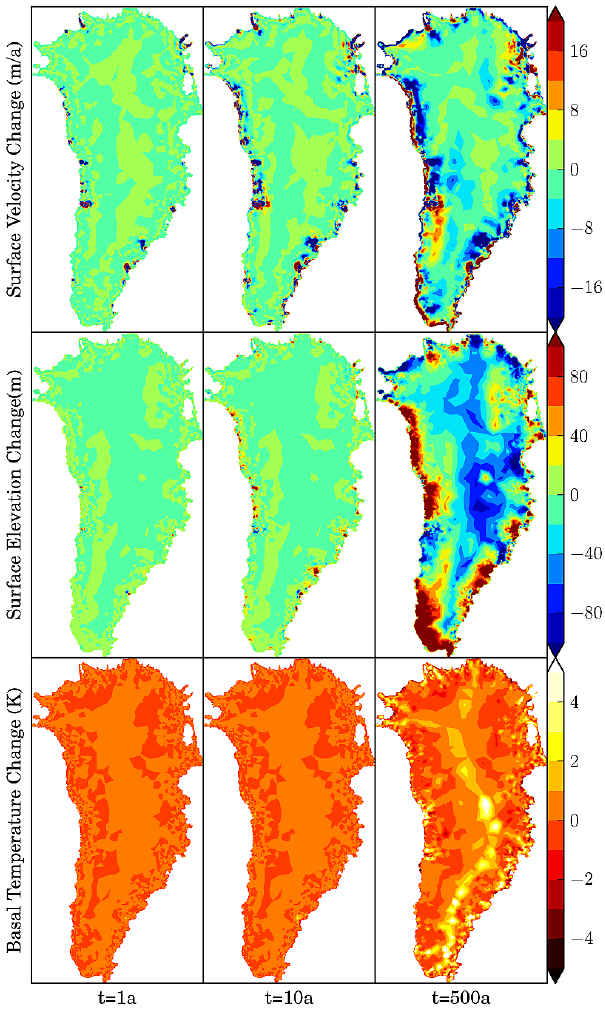
Fig. 15. Velocity, surface elevation, and basal temperature change through a 500-year simulation of the Greenland Ice